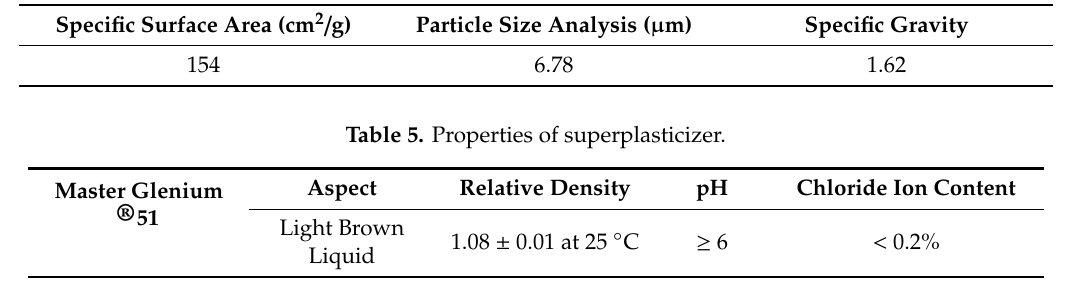
Table 4. Properties of graphene nanoplatelets (GNPs).